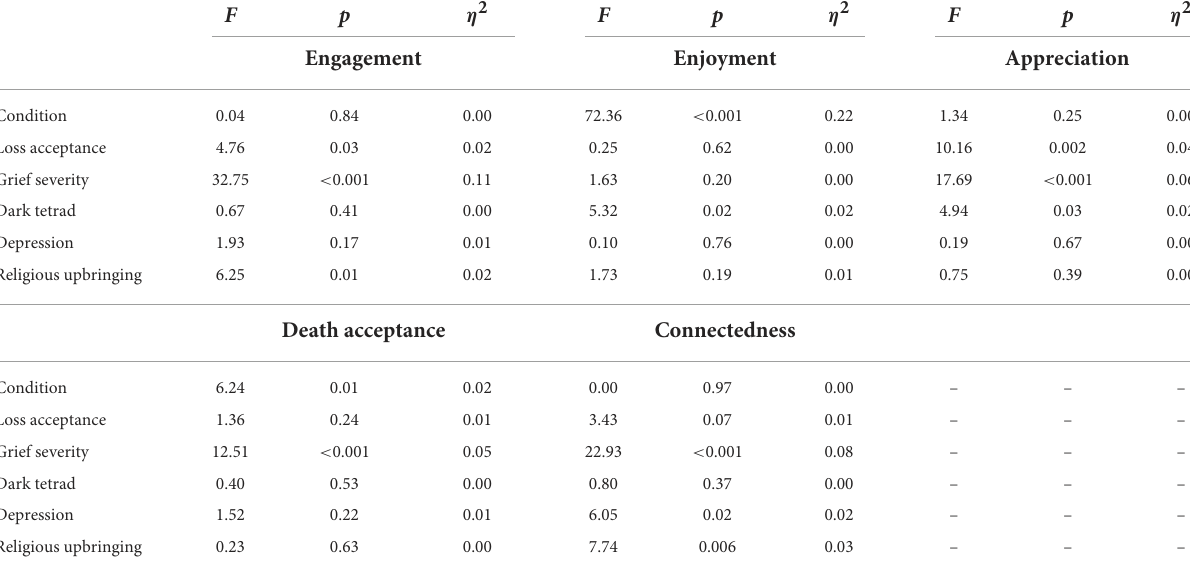
TABLE 2 Between-subject MANCOVA effects of condition and covariates on mediators and outcome variables. F p η 2 Engagement Enjoyment Appreciation